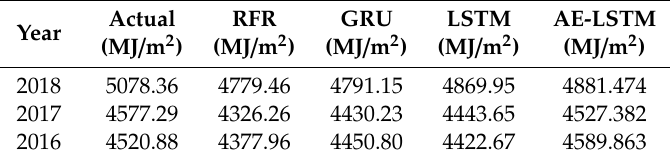
Table 3. Total yearly radiation for different models.